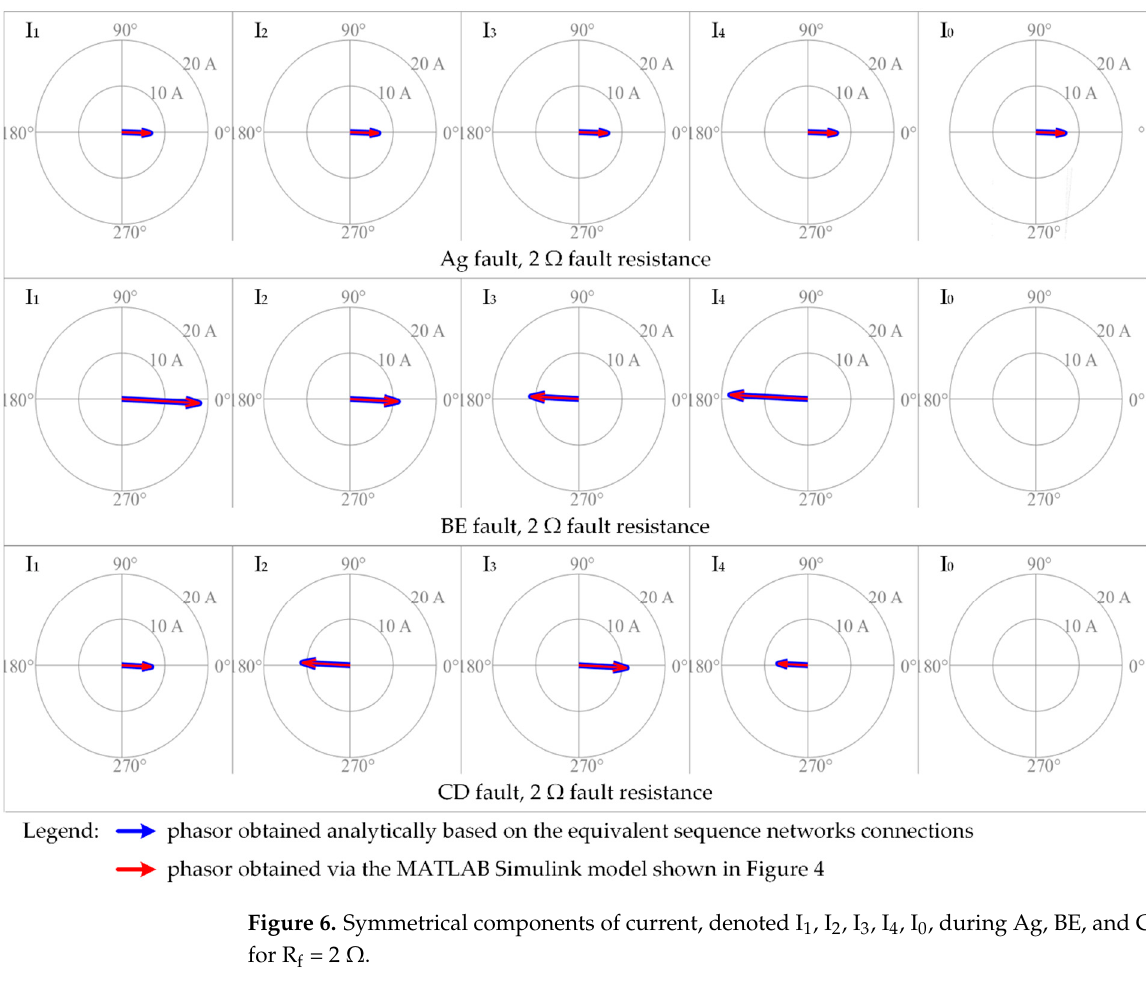
Figure 6. Symmetrical components of current, denoted I 1 , I 2 , I 3 , I 4 , I 0 , during Ag, BE, and CD faults for R f = 2 Ω .